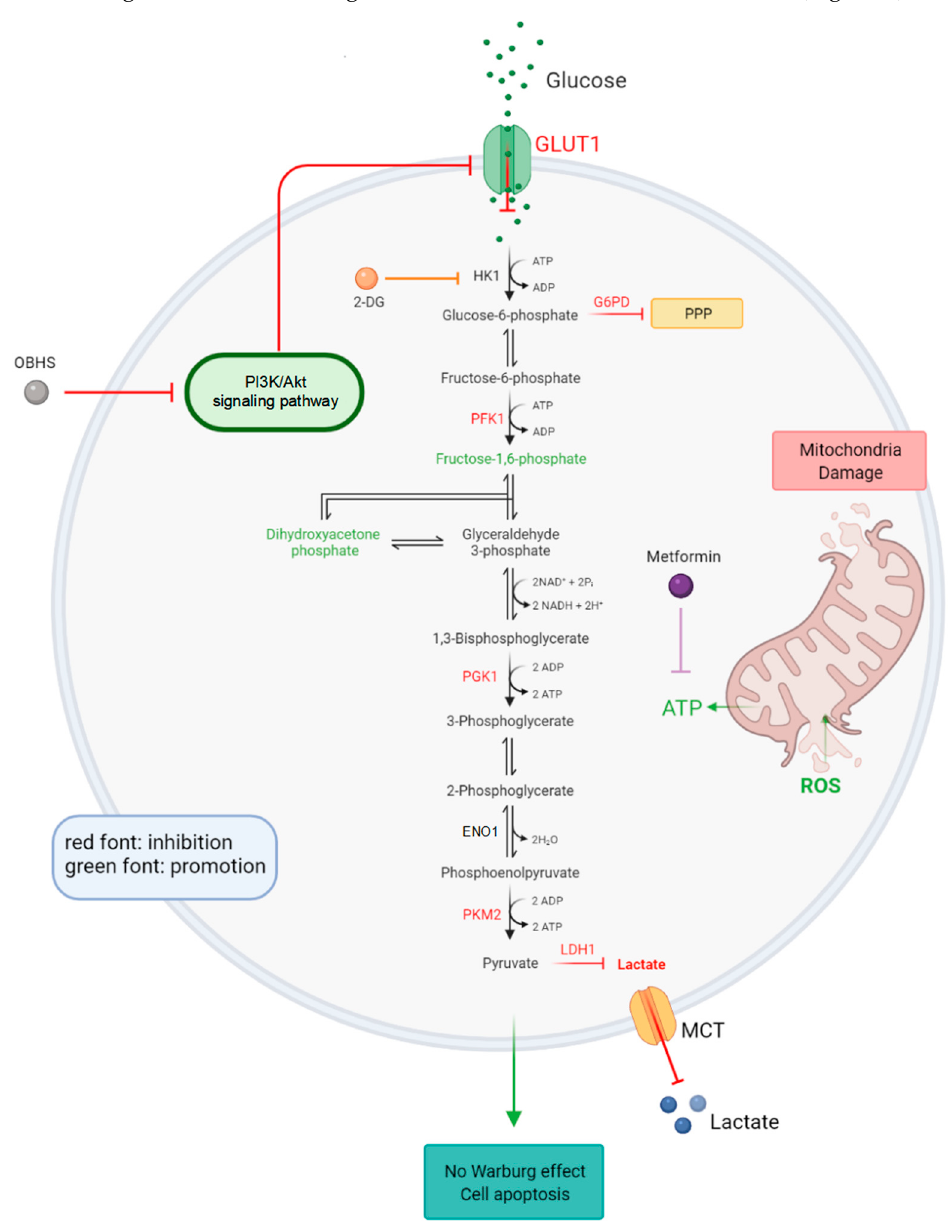
Figure 7. Proposed mechanism of which OBHS remodels abnormal glycometabolism, referring the experiment results. The inhibited pathway or reaction is shown in the red font, and the promoted pathway or reaction is shown in the green font.